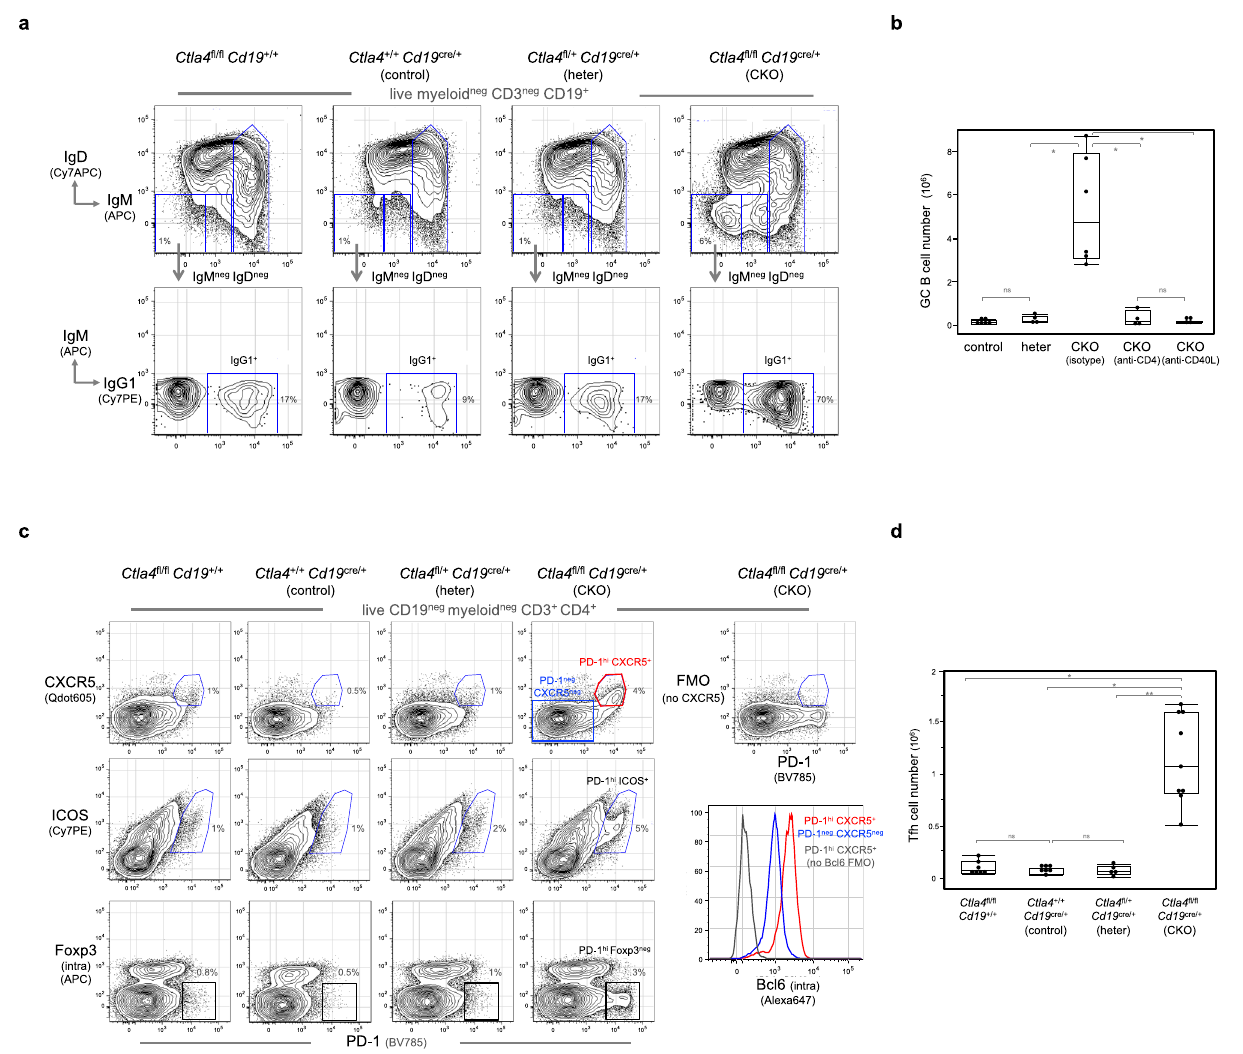
Fig. 3 T-dependent GC responses and Tfh cells arise spontaneously in spleens of CKO mice. a Spleen cells from indicated mice were analyzed by FACS. Live myeloid neg CD3 neg CD19 + splenic B cells were gated to show IgM neg IgD neg B cells, which were further gated to reveal IgG1 + cells. b